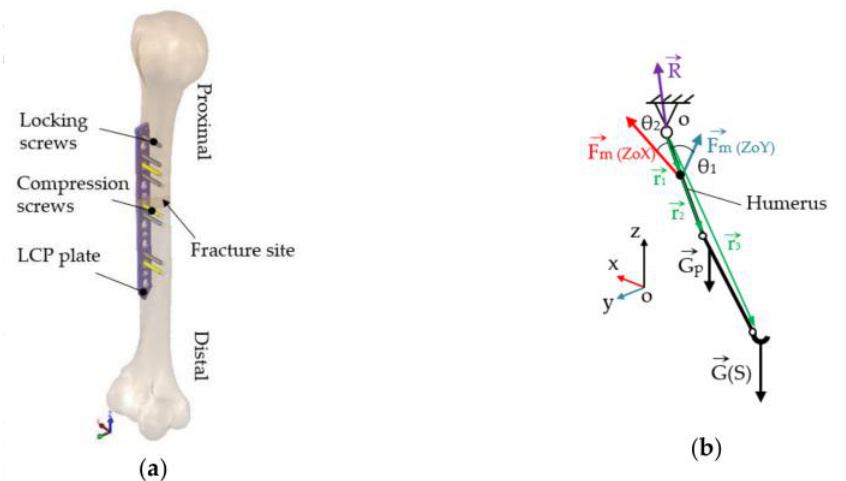
Figure 3. Geometric assembly and simplified static model: ( a ) Reconstructed humerus and LCP system fixed in place—internal lateral view; ( b ) Simplified body diagram of the upper limb used for computation of muscle